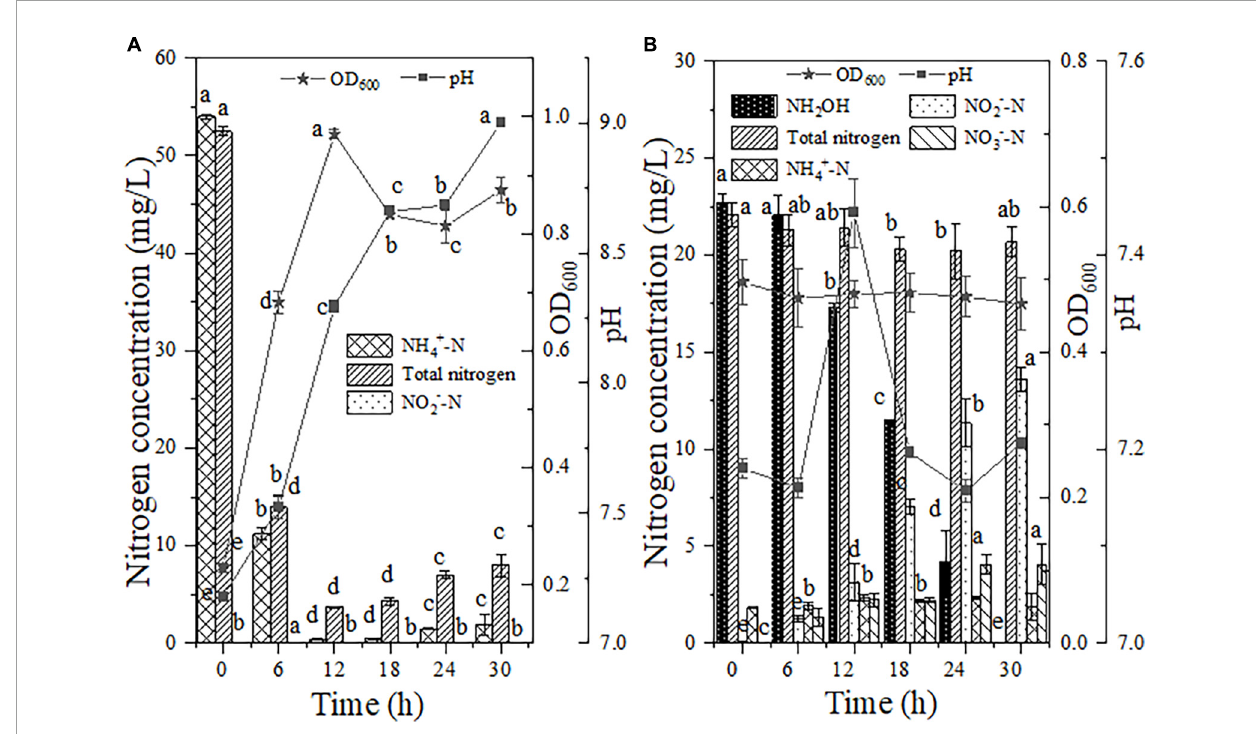
FIGURE3 The heterotrophic nitrification characteristics of strain EN-J1. (A) Ammonium (NH 4 + -N); (B) hydroxylamine (NH 2 OH). Values are means ± SD. Different letters represent significant differences between treatments ( p <